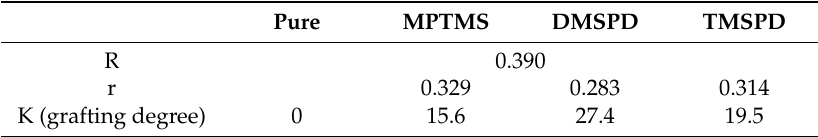
Figure 5. FTIR spectra of the modified silica cake with the prepared SCAs. Table 3. The grafting degree values of the prepared